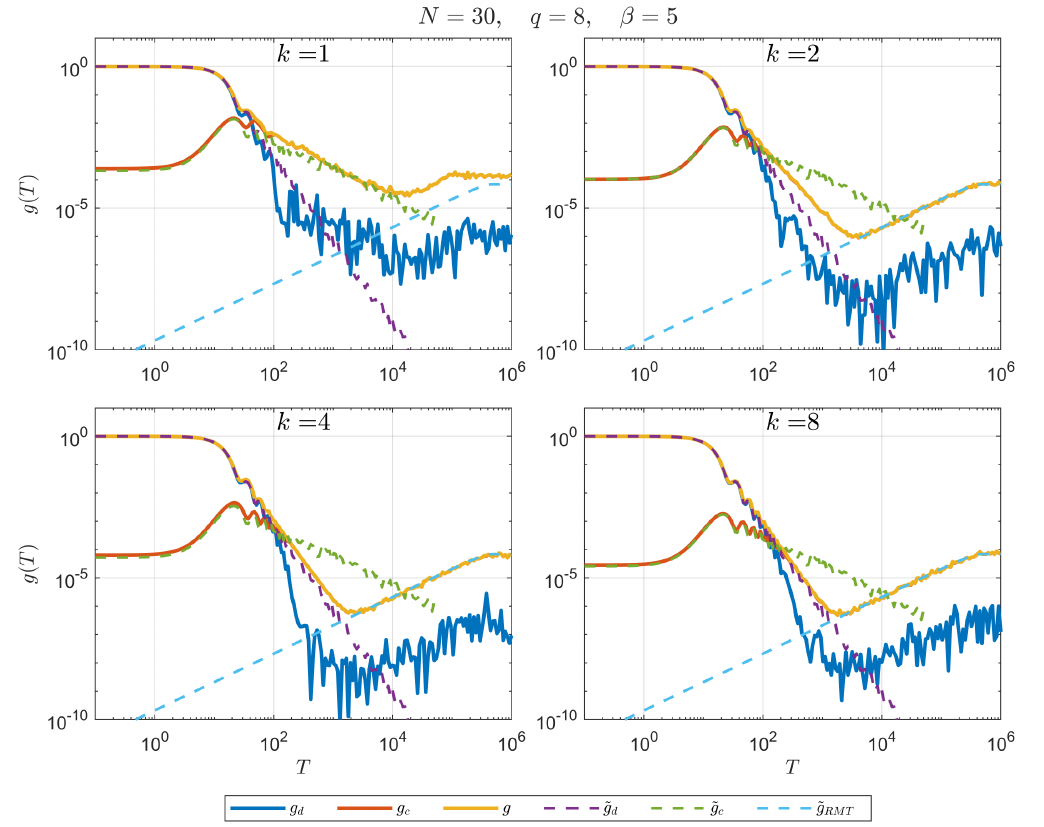
Figure 6 . Full spectral form factor g , connected part g c , and disconnected part g d , obtained by exact diagonalization of the sparse SYK Hamiltonian define over a regular hypergraph, and averaged over 100 disorder realizations of the random couplings. These are compared to the analytical Q – Gaussian approximation ˜ g , ˜ g , and ˜ g c d RMT